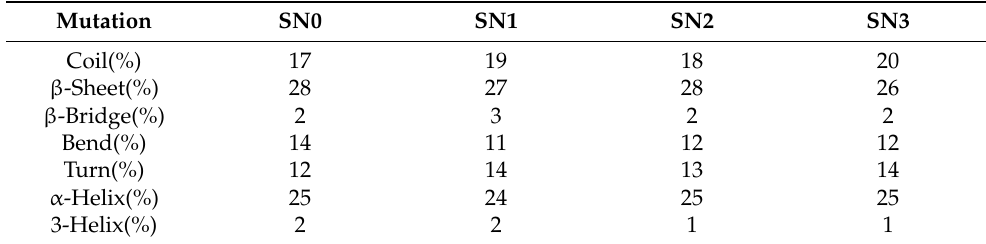
Table 1. Secondary structure statistics of mutation systems.